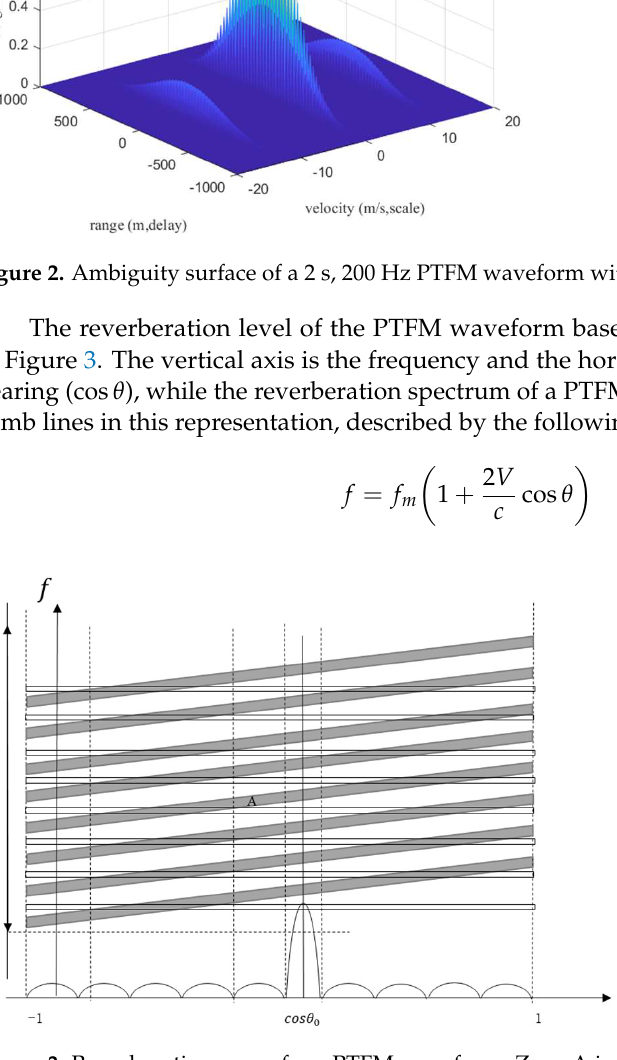
Figure 3. Reverberation zones for a PTFM waveform. Zone A is the grey striped band, The zone in the middle of zone A is zone B.